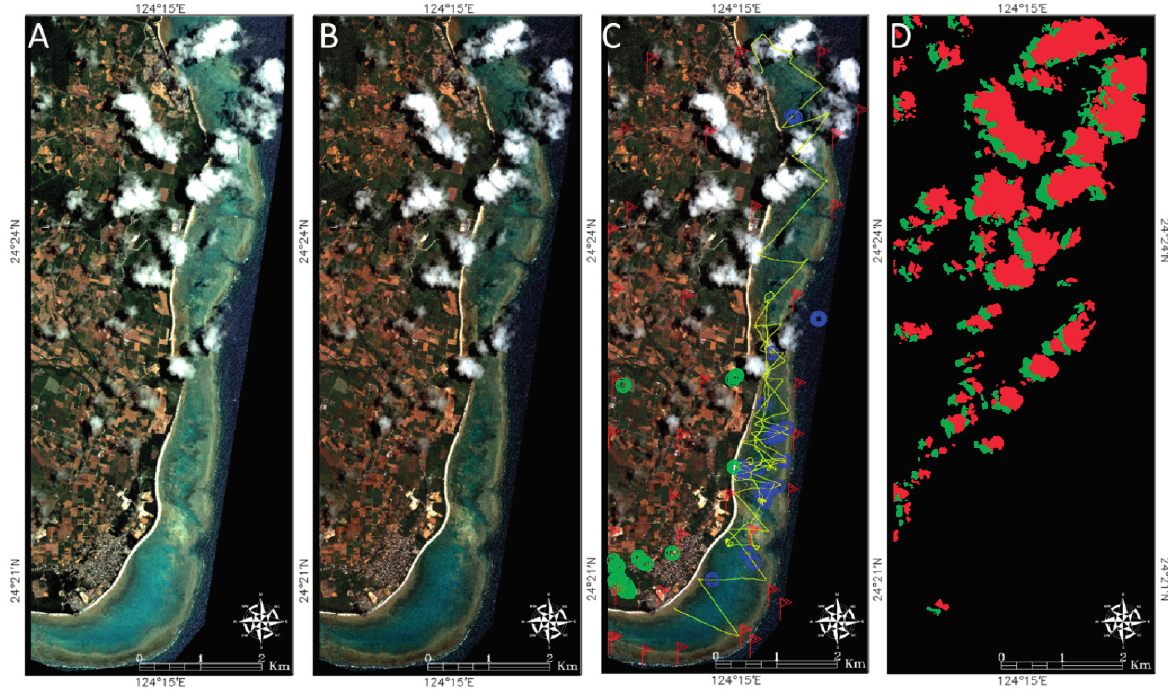
Figure 4. Natural-colored (RGB) images of the study site stemming from ( A ) Google Earth-derived very high resolution mosaic and ( B ) QuickBird pansharpened imagery. ( C ) Natural-colored image of the study site overlaid by ground-truth locations: red flags symbolize the locations of the 45 ground control points; blue squares ( n = 1005) and circles ( n = 495) represent marine training and validation points, respectively, and green squares ( n = 737) and circles ( n = 363) represent the land training and validation points, respectively; yellow dots represent the location of the 22,481 acoustic measurements. ( D ) Mask image of the clouds (in red) and related shadows (in